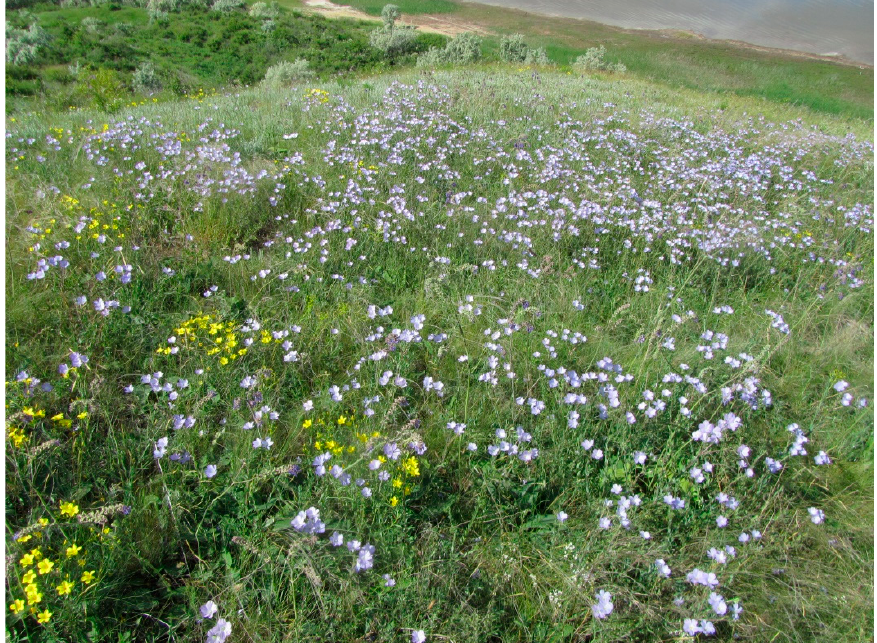
Figure 2. Plant communities on the slope of the left bank of the Kuyalnik Estuary. A fragment of the community Stipo lessingianae-Salvietum nutantis with an aspect of Linum hirsutum , and L. flavum is in the foreground (surroundings of Novokubanka village).